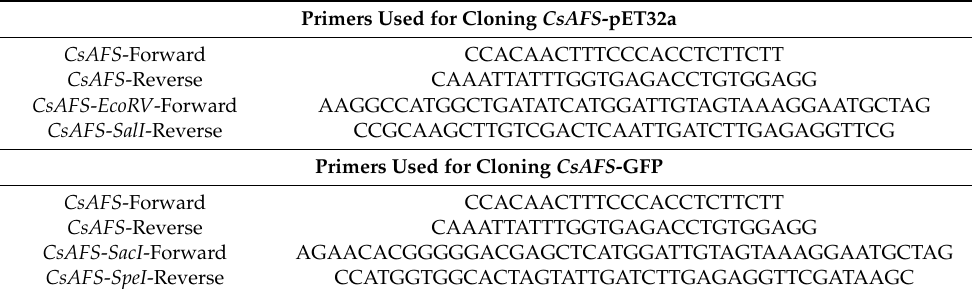
Table 1. Primers used for cloning CsAFS and subcellular location.